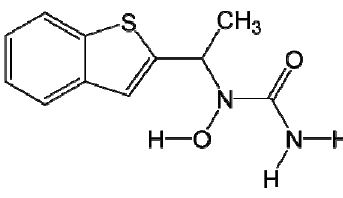
Figure 1. Molecular structure of